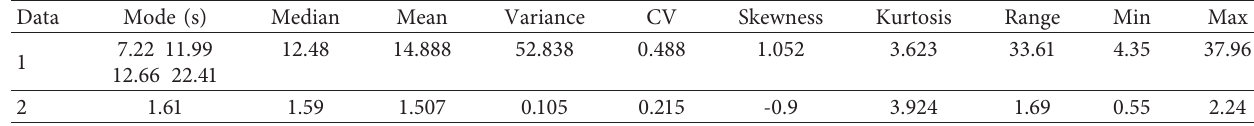
Table 1: Some descriptive statistics for the two datasets.